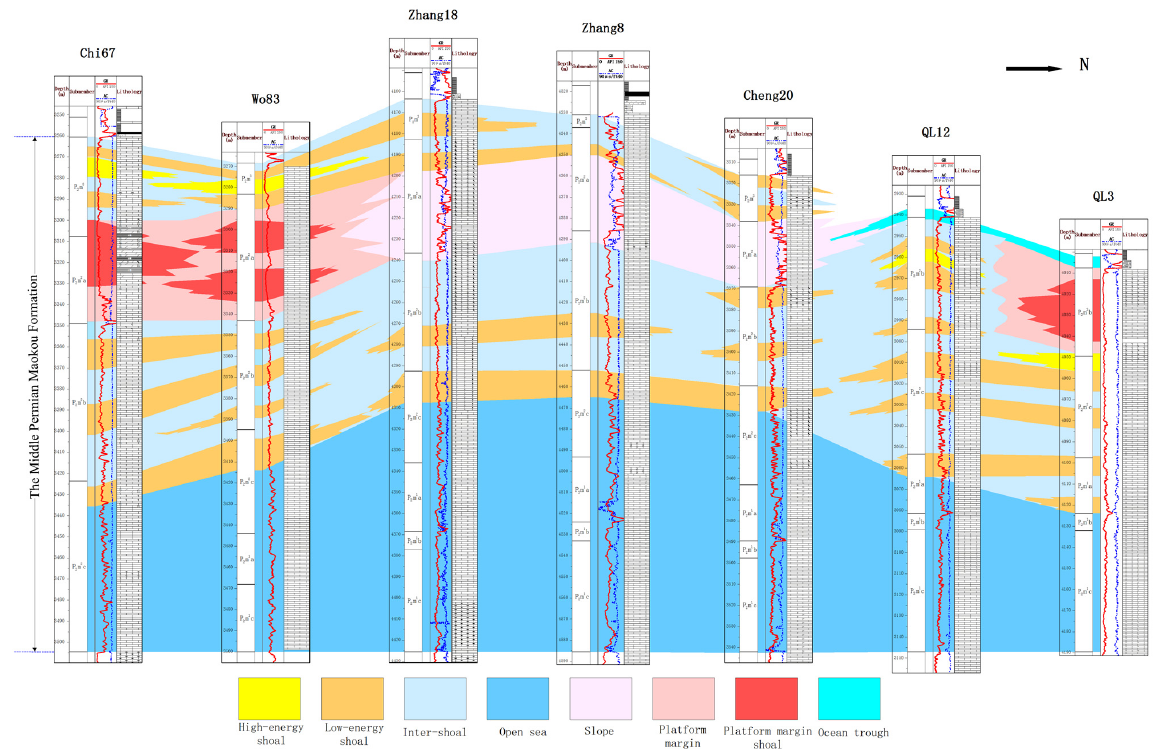
Figure 11. Sedimentary correlation section of wells Sha5-Xiang14-Ban3-Zhang18-Wo79-Wo83-Chi67 in Eastern Sichuan.